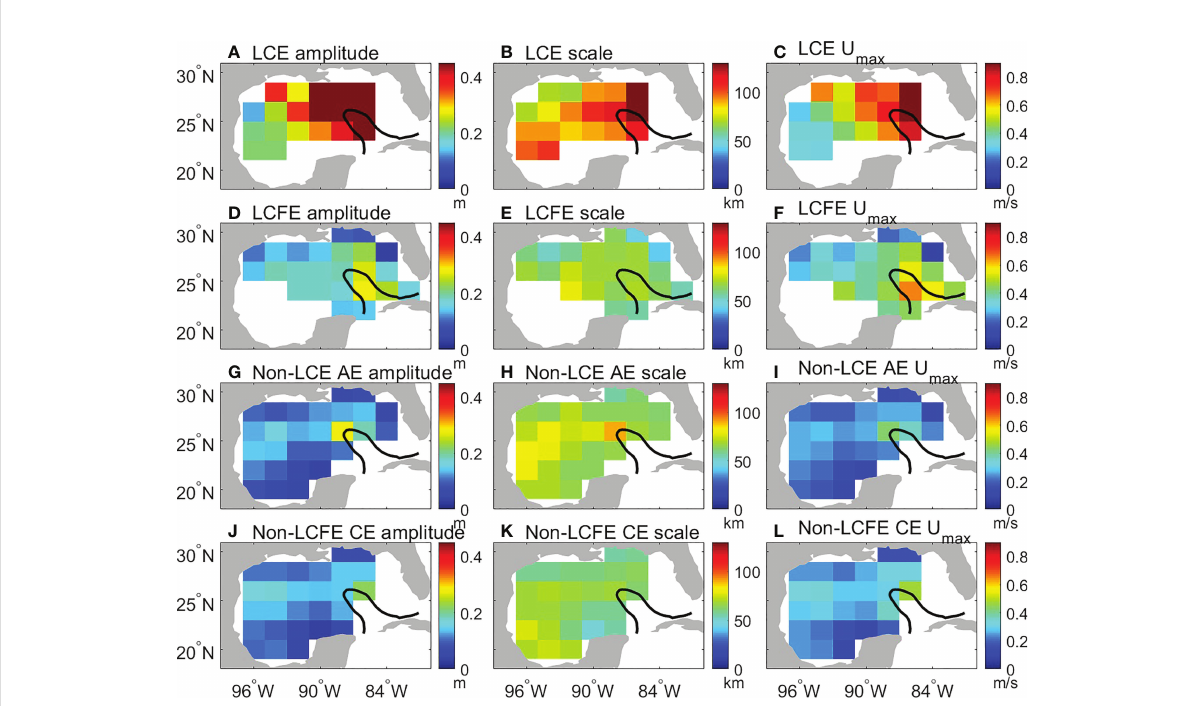
FIGURE 7 Eddy mean amplitude (m) for (A) LCEs, (D) LCFEs, (G) non-LCE AEs, and (J) non-LCFE CEs. Eddy mean scale (km) for (B) LCEs, (E) LCFEs, (H) non-LCE AEs, and (K) non-LCFE CEs. Eddy mean maximum rotational speed (m/s) for (C) LCEs, (F) LCFEs, (I) non-LCE AEs, and (L) non-LCFE CEs. The black line represents the 25-cm contour of temporal mean SSH anomalies from 1993 to